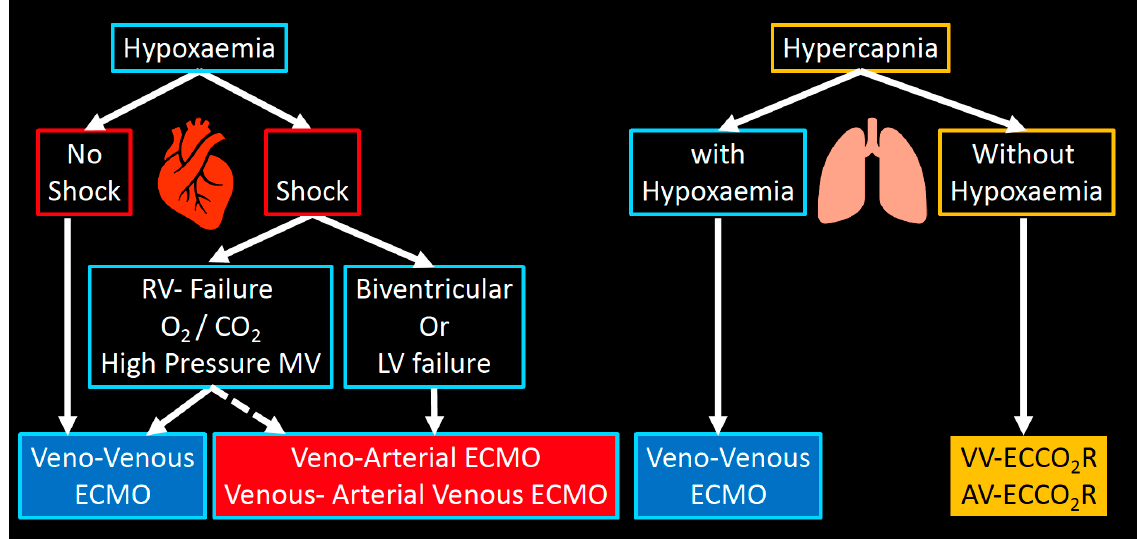
Figure 1. ECLS modalities. Overview of the available extracorporeal support modalities and their role in the management of respiratory failure.